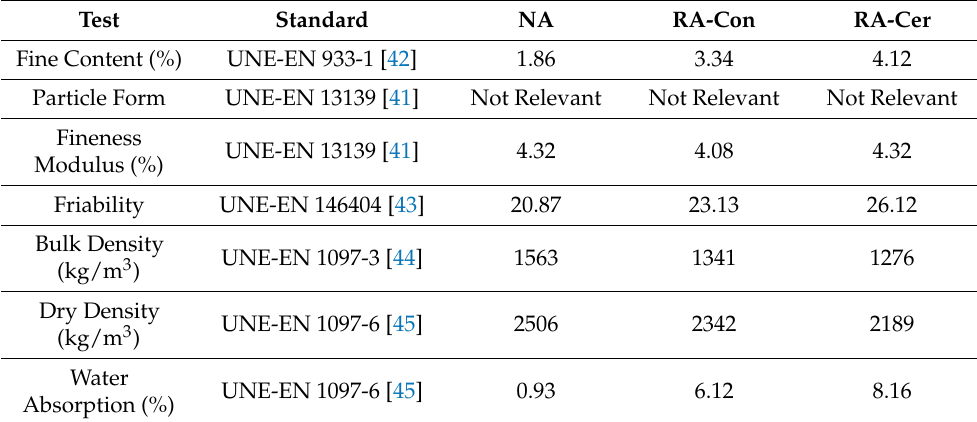
Table 2. Physical characterization of the aggregates used.